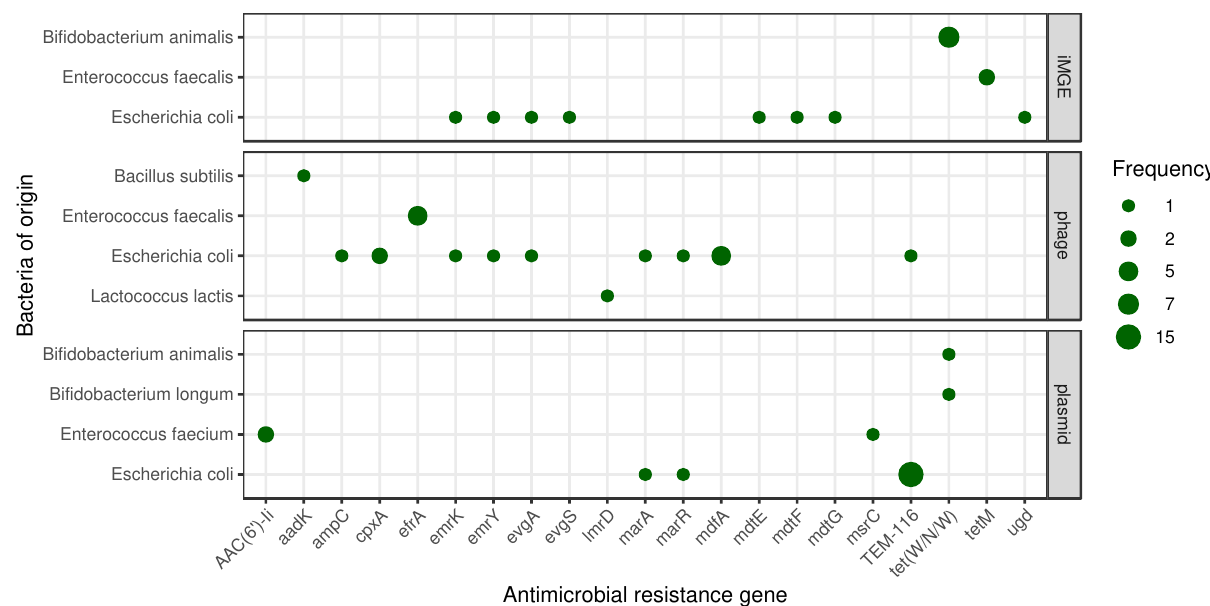
Figure 3. Mobile antimicrobial resistance gene frequency by bacteria of origin. The size of the dots indicates the occurrence frequency of the given gene flanked by iMGE, positioned in plasmid or